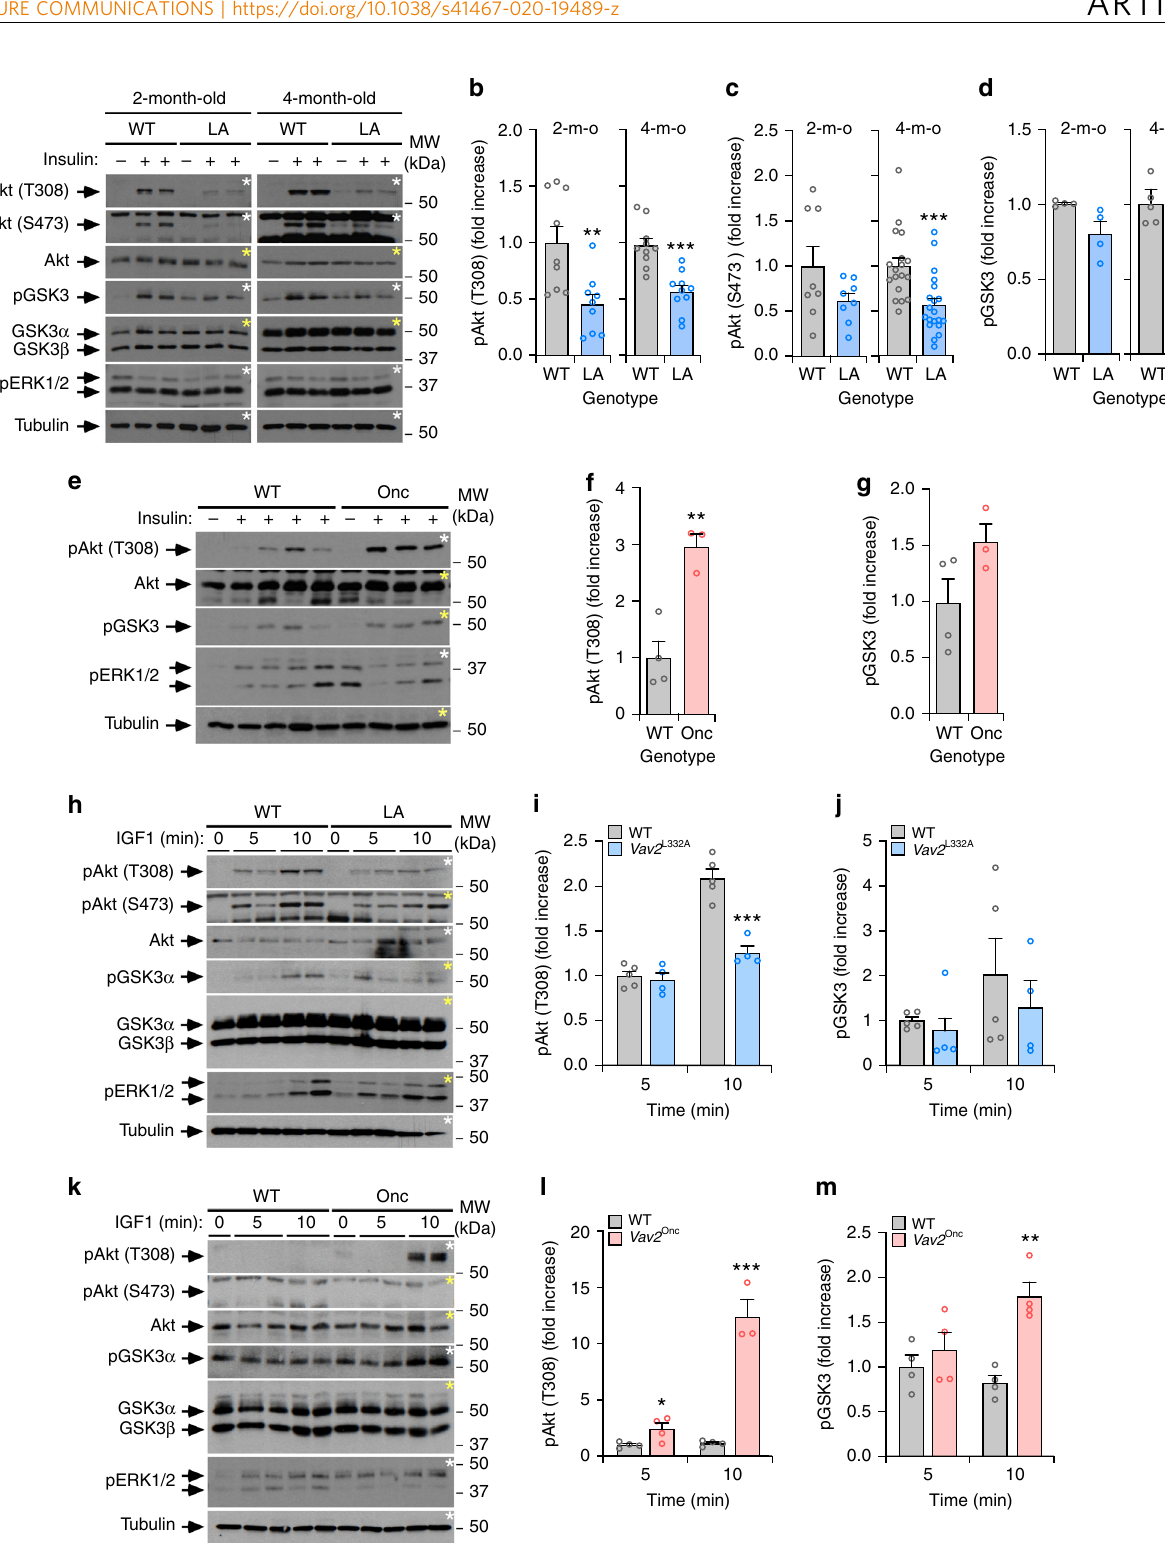
(Supplementary Fig. 3g, h) in Vav2 L332A/L332A mice. We did not detect either any signaling alteration in the liver of Vav2 Onc/Onc mice (Supplementary Fig. 3e, f). However, we did fi nd higher levels of insulin-induced Akt phosphorylation in WAT from 4-month-old Vav2 Onc/Onc mice (Supplementary Fig. 3g, h). Reduced phosphorylation of Akt in Thr 308 is also observed in 4-month-old Vav2 L332A/L332A mice infused with IGF1 (Fig. 2h,